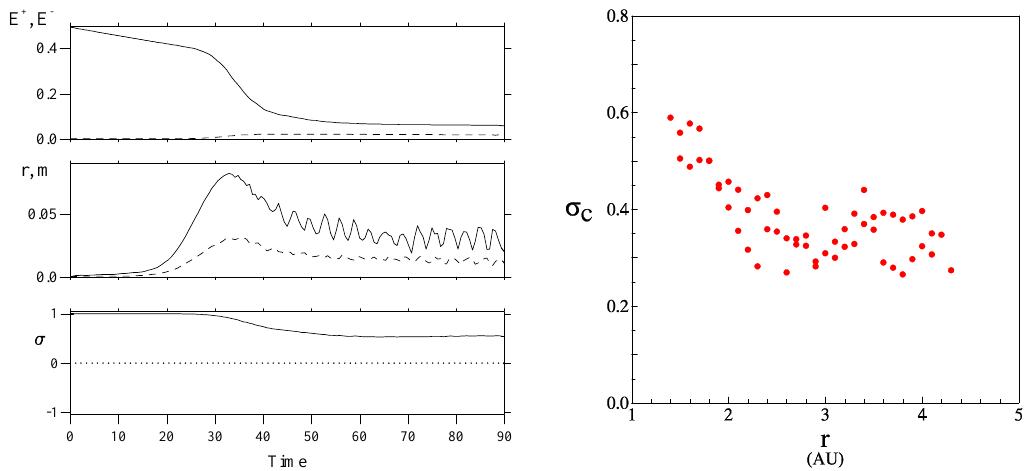
Figure 70: Top left panel: time evolution of e + (solid line) and e – (dashed line). Middle left panel: density (solid line) and magnetic magnitude (dashed line) variances. Bottom left panel: normalized cross helicity 𝜎 c . Right panel: Ulysses observations of 𝜎 c radial evolution within the polar wind (left column is from Malara et al. , 2001b, right panel is a courtesy of B. Bavassano).